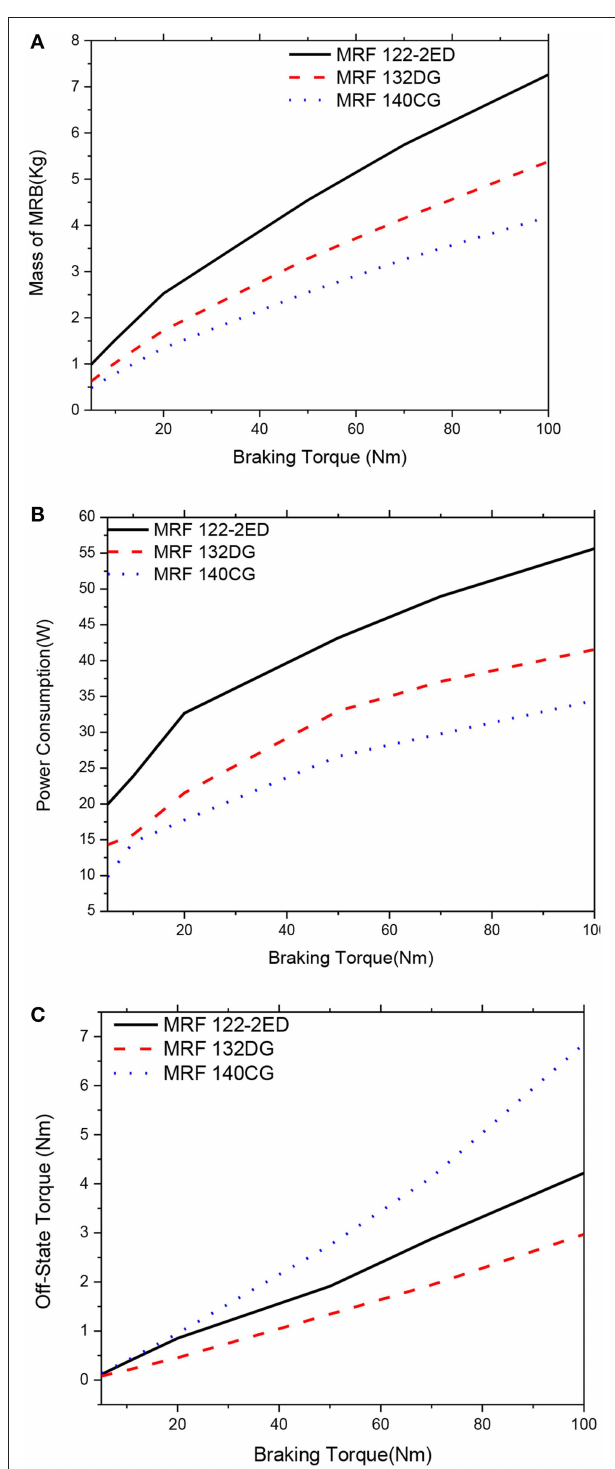
FIGURE 8 | Mass optimization results of the MRBs as a function of braking torque of conventional MRB, d = 0.8mm. (A) Mass as a function of braking torque, (B) Power consumption as a function of braking torque, (C) Off-state torque as a function of braking torque.